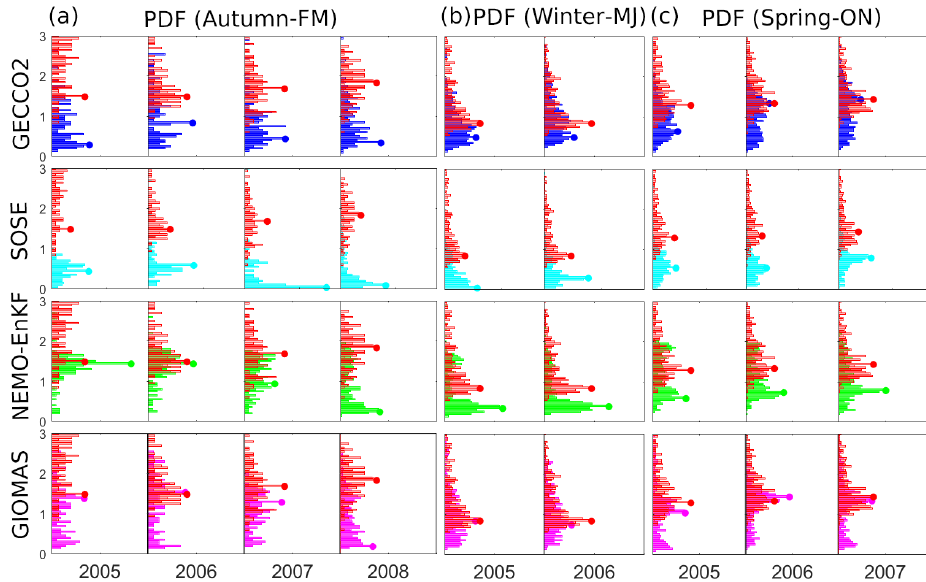
Figure 5. The variation in monthly ice thickness distribution from GECCO2 (blue), SOSE (cyan), NEMO-EnKF (green), GIOMAS (pink) and ICESat-1 (red) in Autumn-FM (a) , Winter-MJ (b) and Spring-ON (c) . The colored dots represent the modal ice thickness.